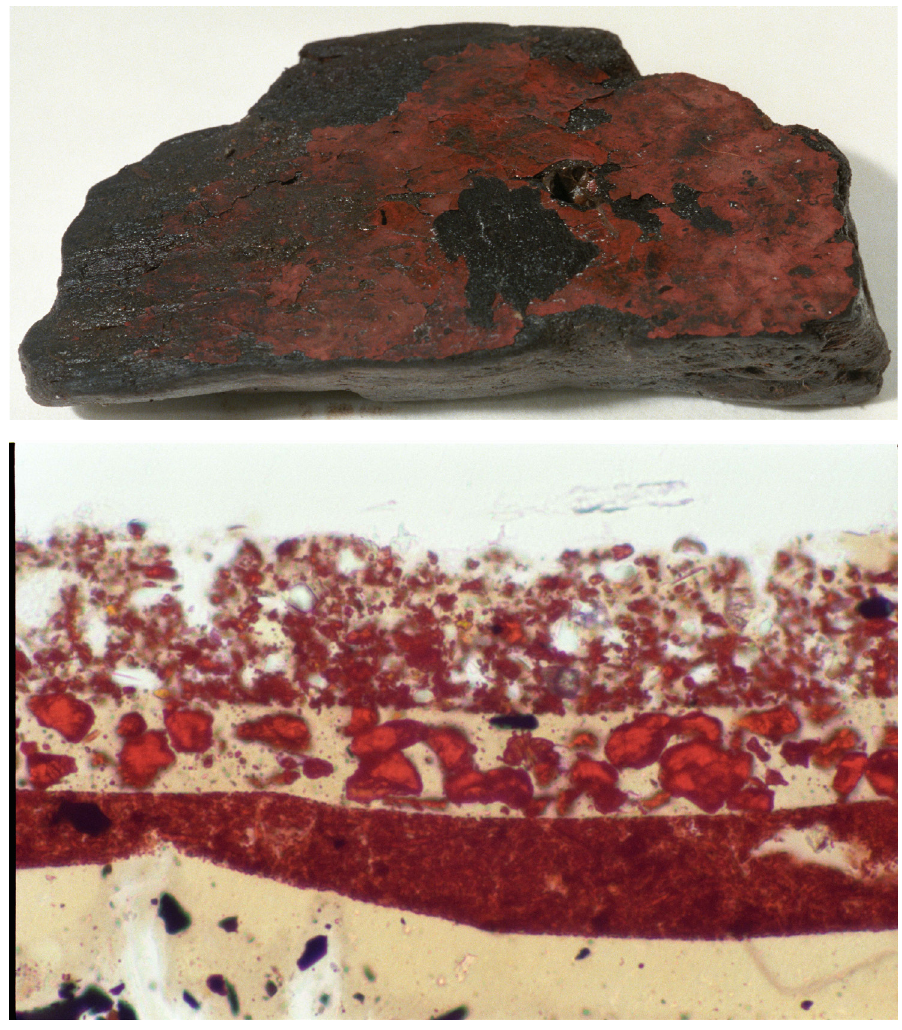
Figure 2. Red lacquer coating on wood and microphotograph of its section. Photographs kindly provided by Masaharu Naga- shima with